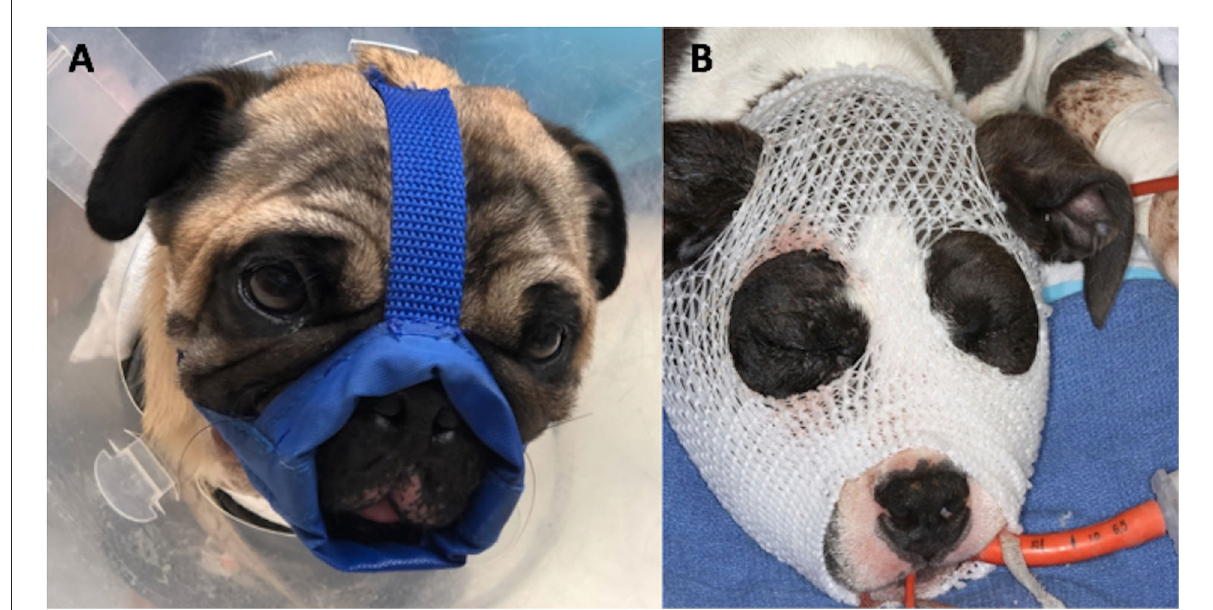
FIGURE1 Placement of nylon muzzle holds the jaw in relative normocclusion by decreased mouth opening. It is especially useful for caudal mandibular and temporomandibular (TMJ) fractures and can be custom-made to adapt brachycephalic skull conformation (A) . The “face mask” (B) , using an elastic dressing retainer, can be applied in cases where maxillary fractures are present as it provides even pressure and stability to the entire face.